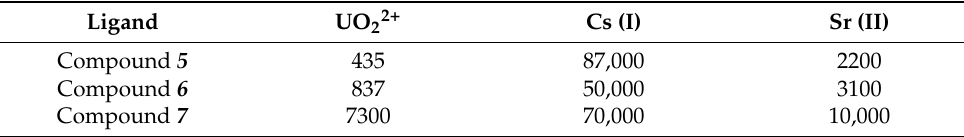
Table 1. Separation factor values of Np (IV) and Pu (IV).